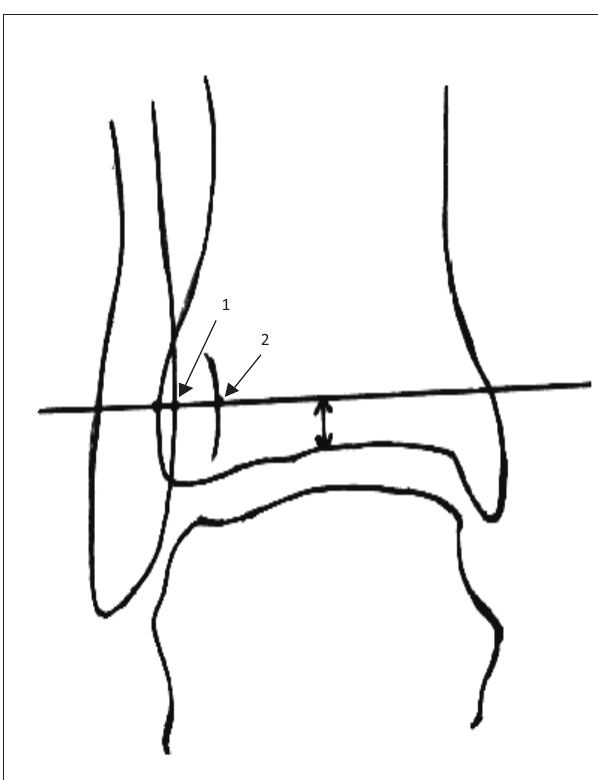
FIGURE 2: Diagram demonstrating the tibiofibular clear space and overlap: The clear space is the distance between: (1) the medial border of the distal fibula and (2) the lateral border of the posterior tibial prominence, measured 1 cm above the tibial plafond.